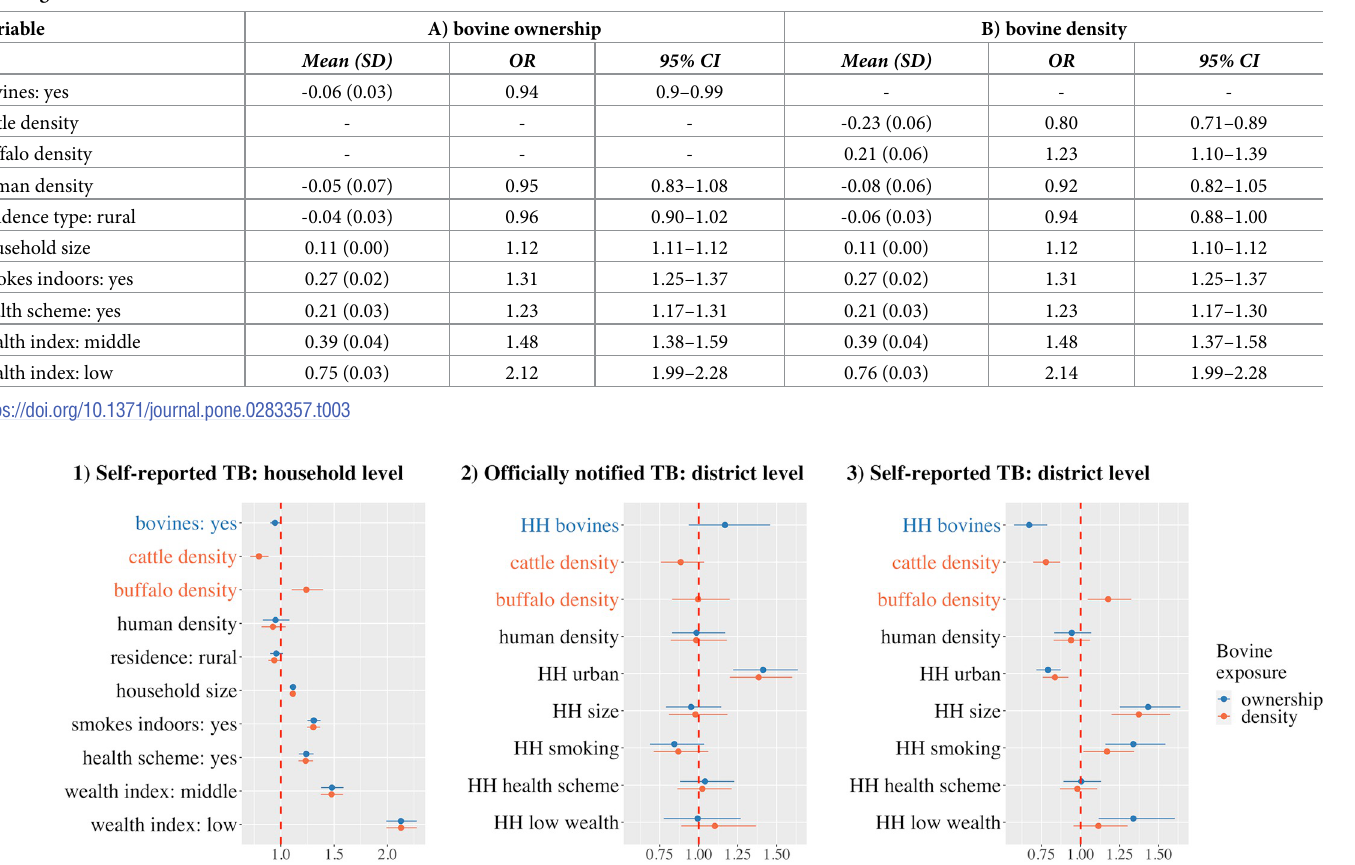
Table 3. Posterior estimates of mean fixed effects, standard deviation (SD), odds ratio (OR) and 95% credible interval (CI) from Bayesian inference (INLA) of self- reported human tuberculosis in households (model 1) for the two exposure measures bovine ownership in households (A) or cattle and buffalo density (B) and con- founding variables.